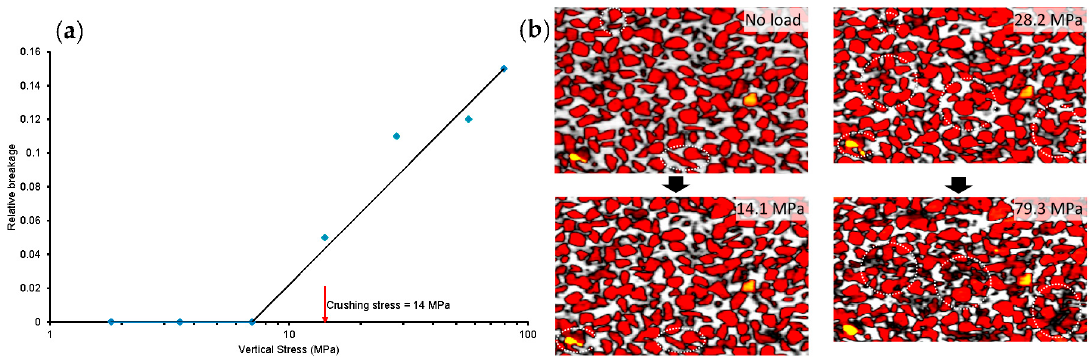
Figure 13. Particle breakage under different vertical stresses: ( a ) relative breakage; ( b ) images showing breakage of particles.